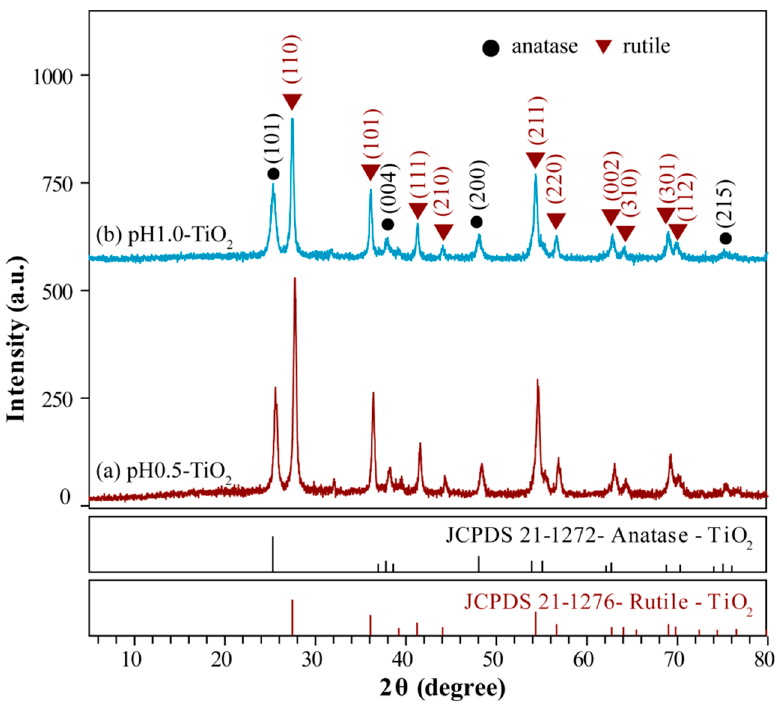
Figure 1. XRD patterns of ( a ) pH0.5-TiO 2 , ( b ) pH1.0-TiO 2 .